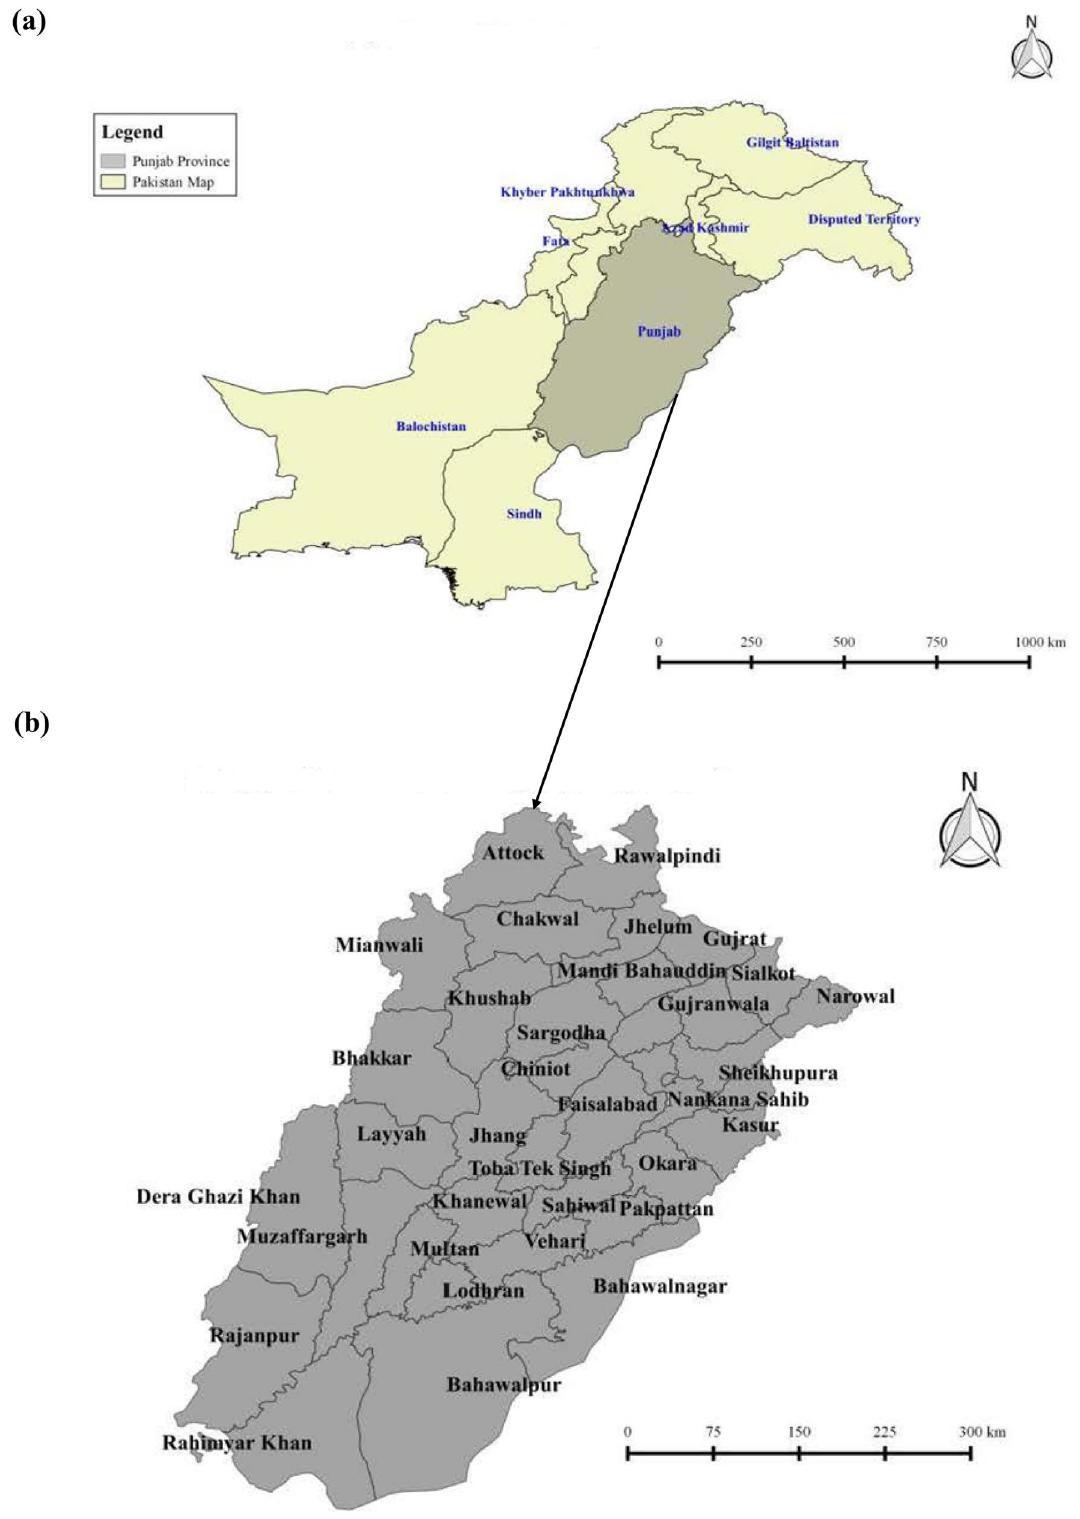
Figure 1. Map of the study region. ( a ) Provinces of Pakistan. ( b ) Districts of Punjab where the present study was